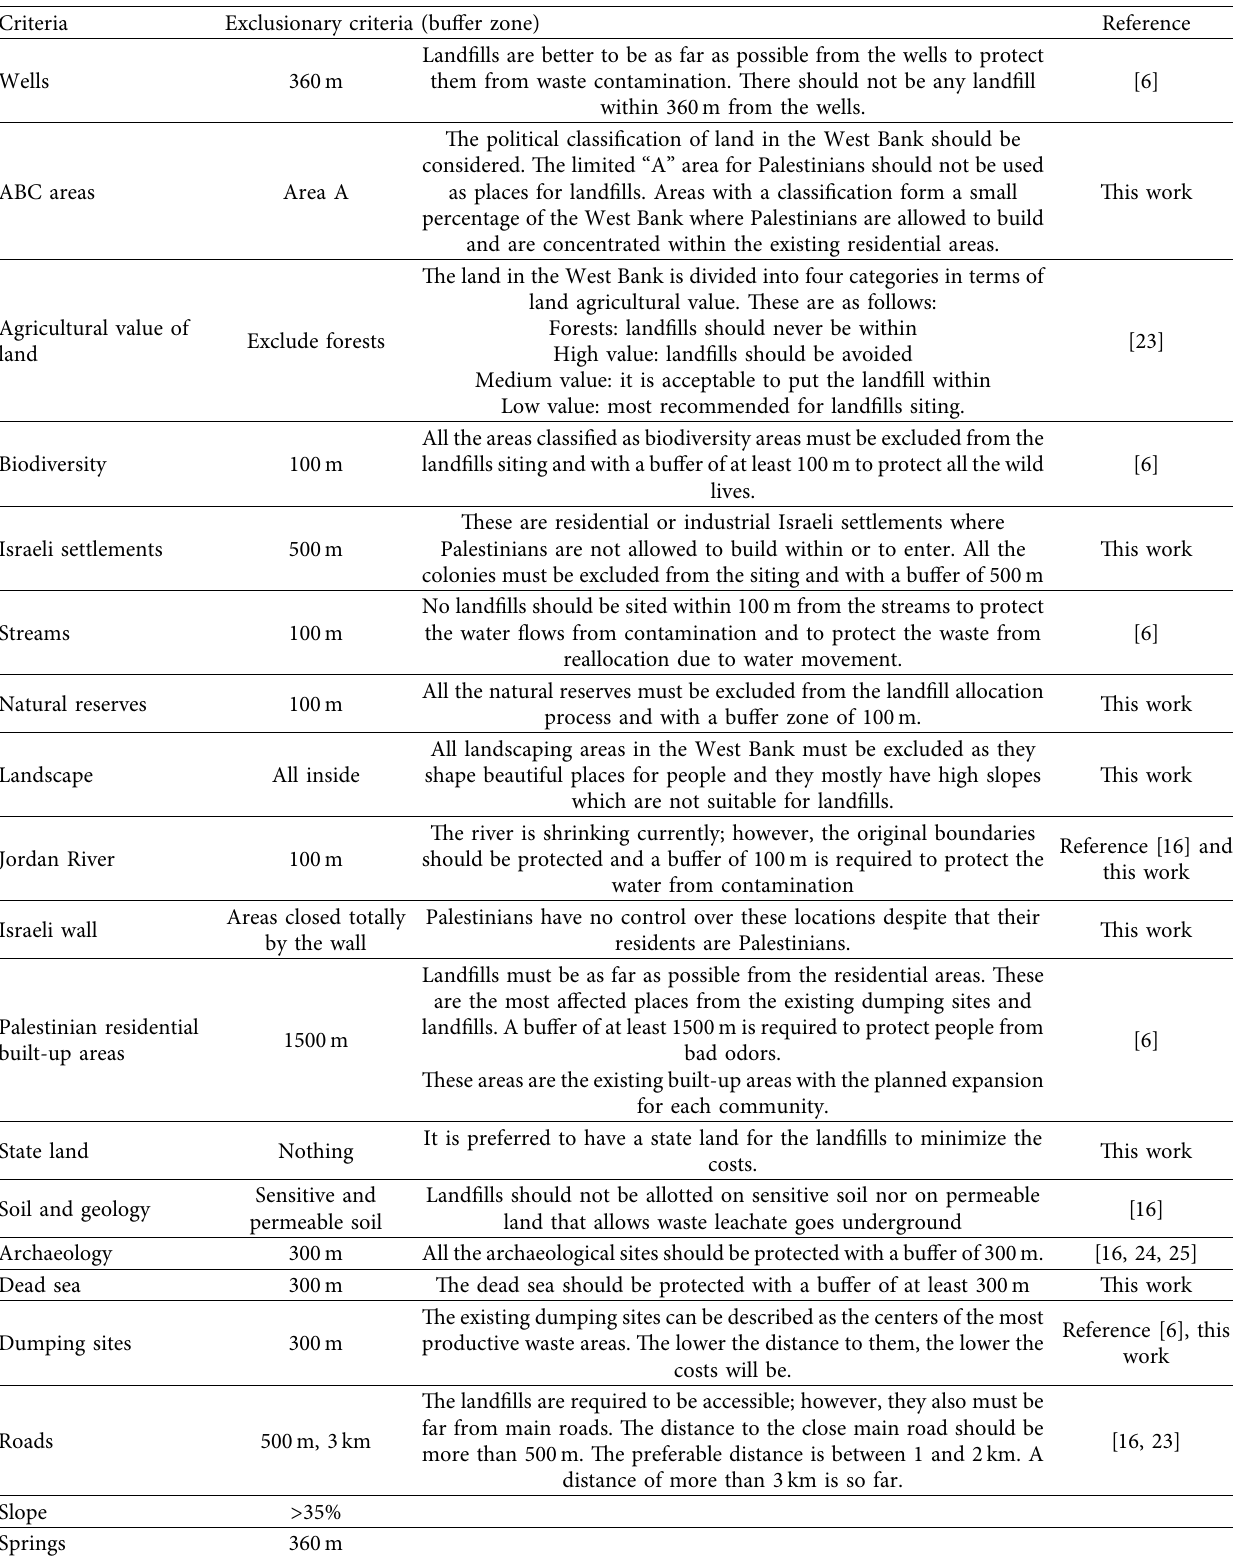
Table 4: Exclusionary criteria for landfill